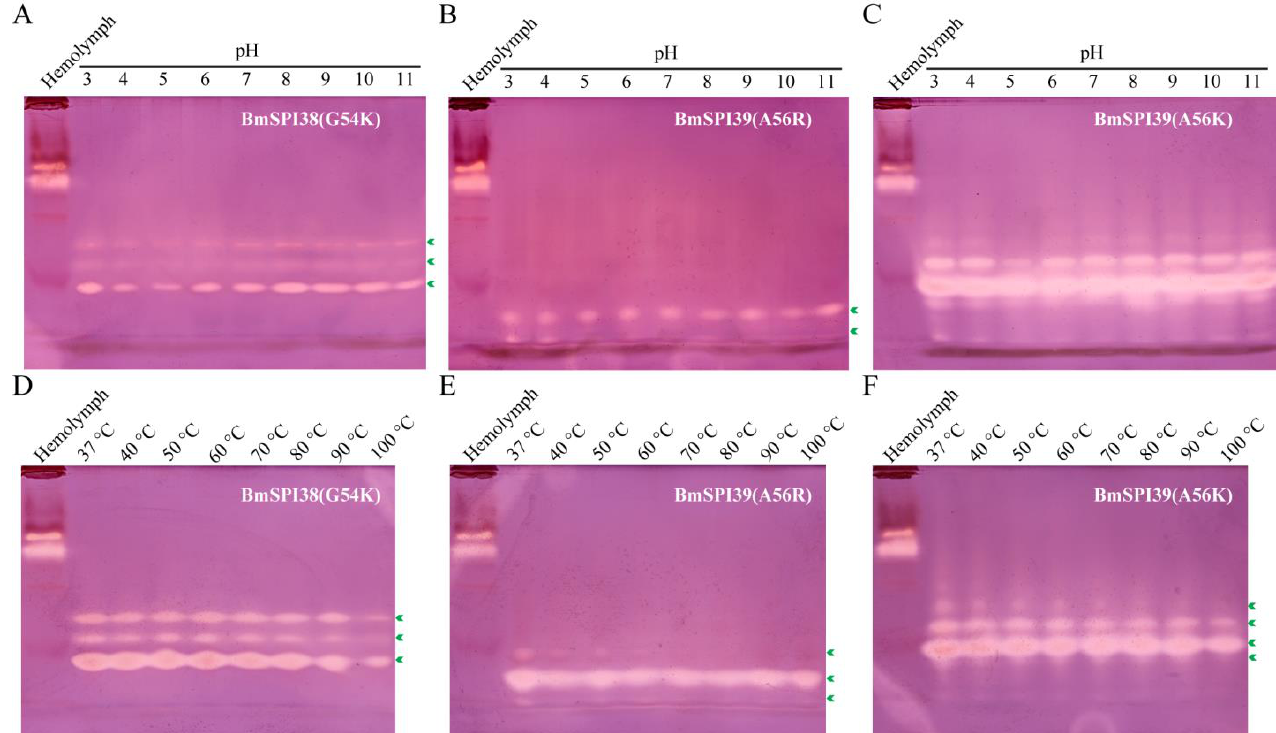
Figure 8. P1 mutants of BmSPI38 and BmSPI39 exhibited strong acid – base and thermal stability. Effect of pH on the activities of BmSPI38(G54K) ( A ), BmSPI39(A56R) ( B ), and BmSPI39(A56K) ( C ). Effect of temperature on the activities of BmSPI38(G54K) ( D ), BmSPI39(A56R) ( E ), and BmSPI39(A56K) ( F ). The inhibitory activity of purified mutant proteins on trypsin after treatment with different pH or temperatures can be assessed by in-gel activity staining. B. mori hemolymph from day 5 fifth-instar larvae was used as positive control. Green arrows indicate the inhibitory-active bands of the P1 mutants against trypsin.